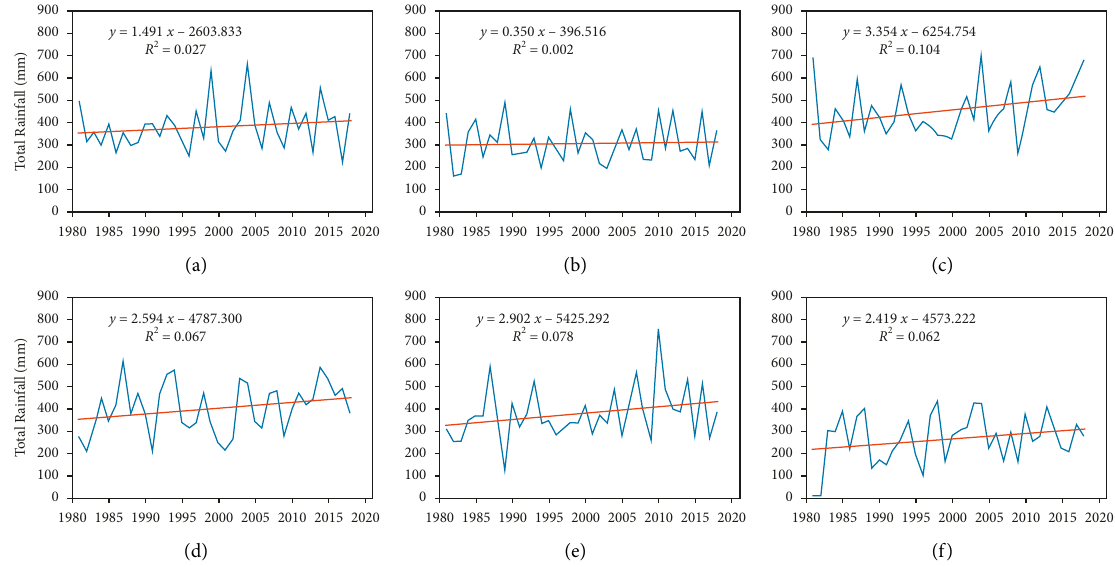
Figure 2: Linear plots of minor seasonal total rainfall amount over stations in the Middle Sector of Ghana: (a) Ho, (b) Akuse, (c) Akim Oda, (d) Sefwi Bekwai, (e) Abetifi, and (f) Akatsi. Data used: in situ rainfall data from the Ghana Meteorological Agency.